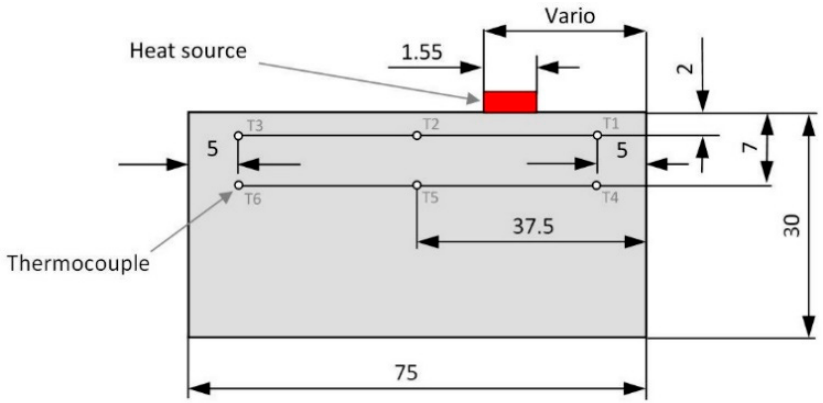
Figure 4. Calculation model generated using the FDM.